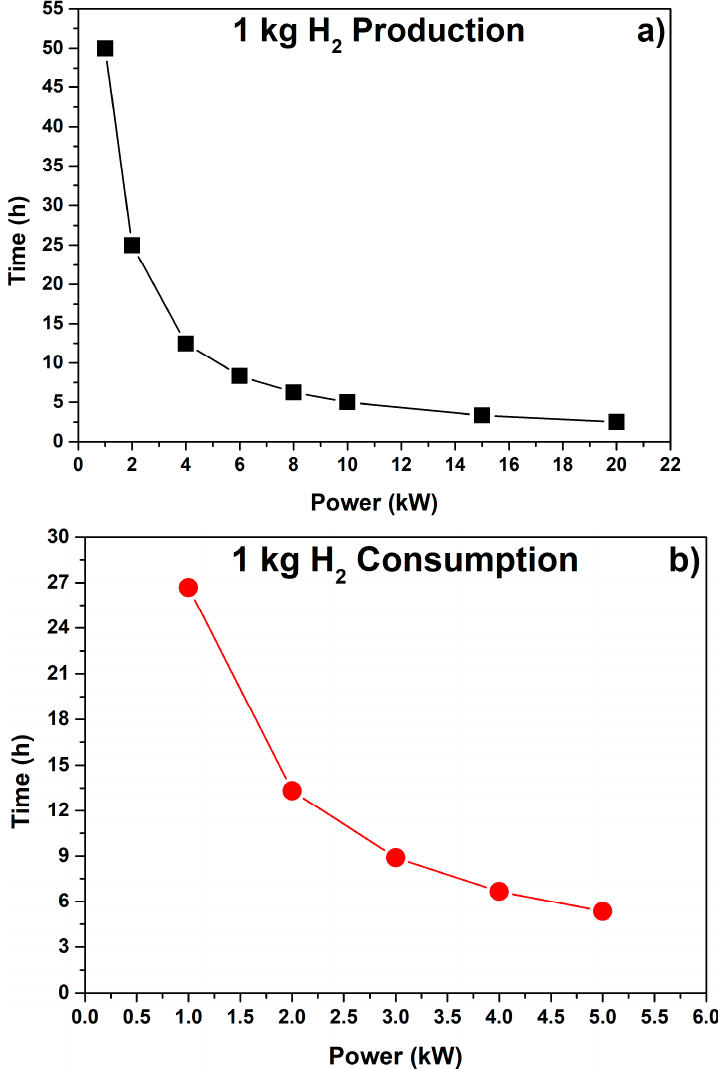
Figure 7. Time for ( a ) production by an electrolyzer and ( b ) consumption by a fuel cell of 1 kg H 2 as a function of power of the equipment.